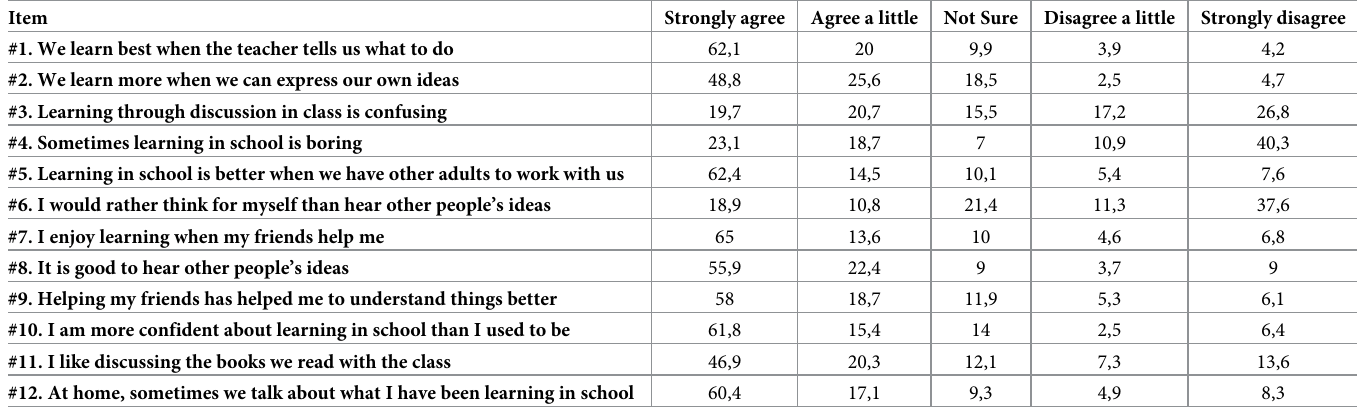
Table 3. Valid percent of students’ answers participating in IGs and DLGs.